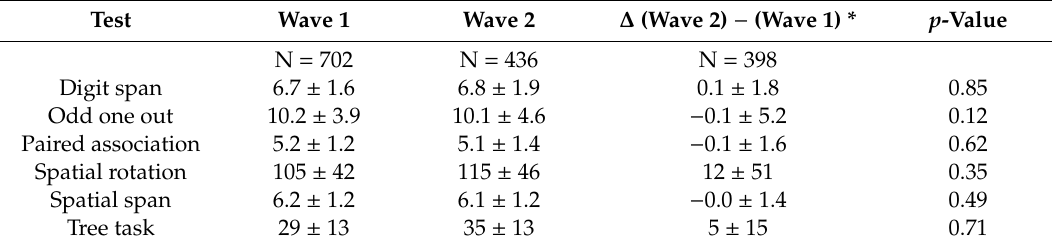
Figure 3. Participants’ drinking pattern at baseline (left column) and after a 1-year follow-up (right column). Width of the arrow and box size varies with but is not fully representative of the number of persons. Percentage of persons changing group is given for most but not all changes. Table 3. Average scores at baseline and one-year follow-up for the six cognition tests.